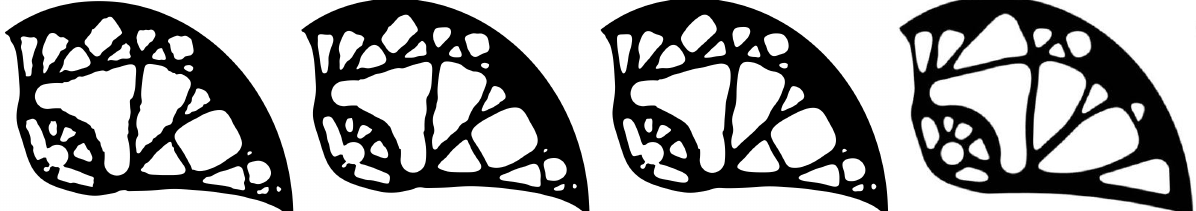
Figure 11. Cam shape after smoothing achieved by calculations using various values of polynomial degrees of k = 5, 10, and 100 (from the left), and the optimal cam design with k = 250